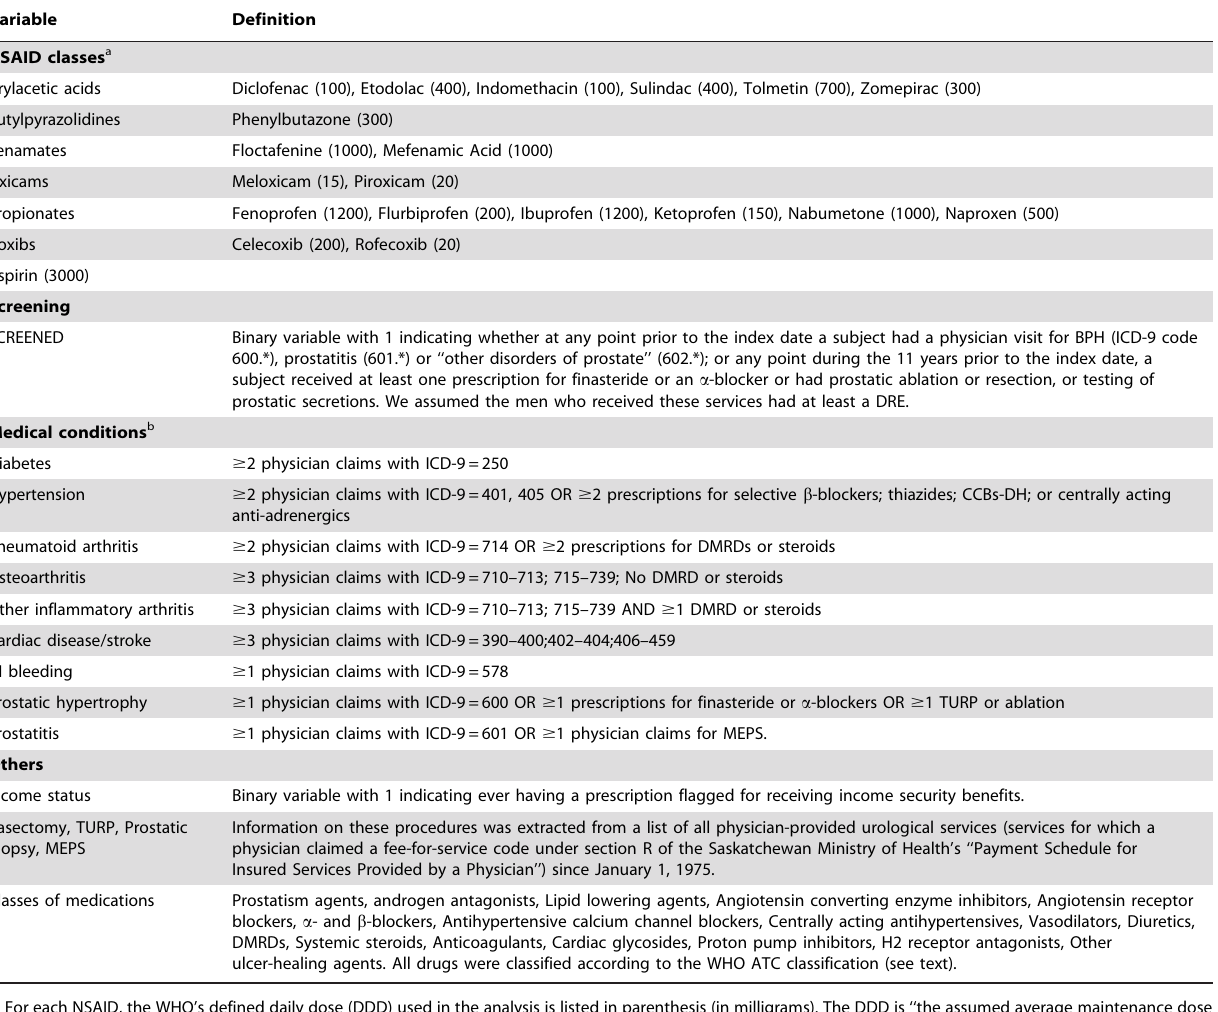
Table 1. Definitions of variables used in the